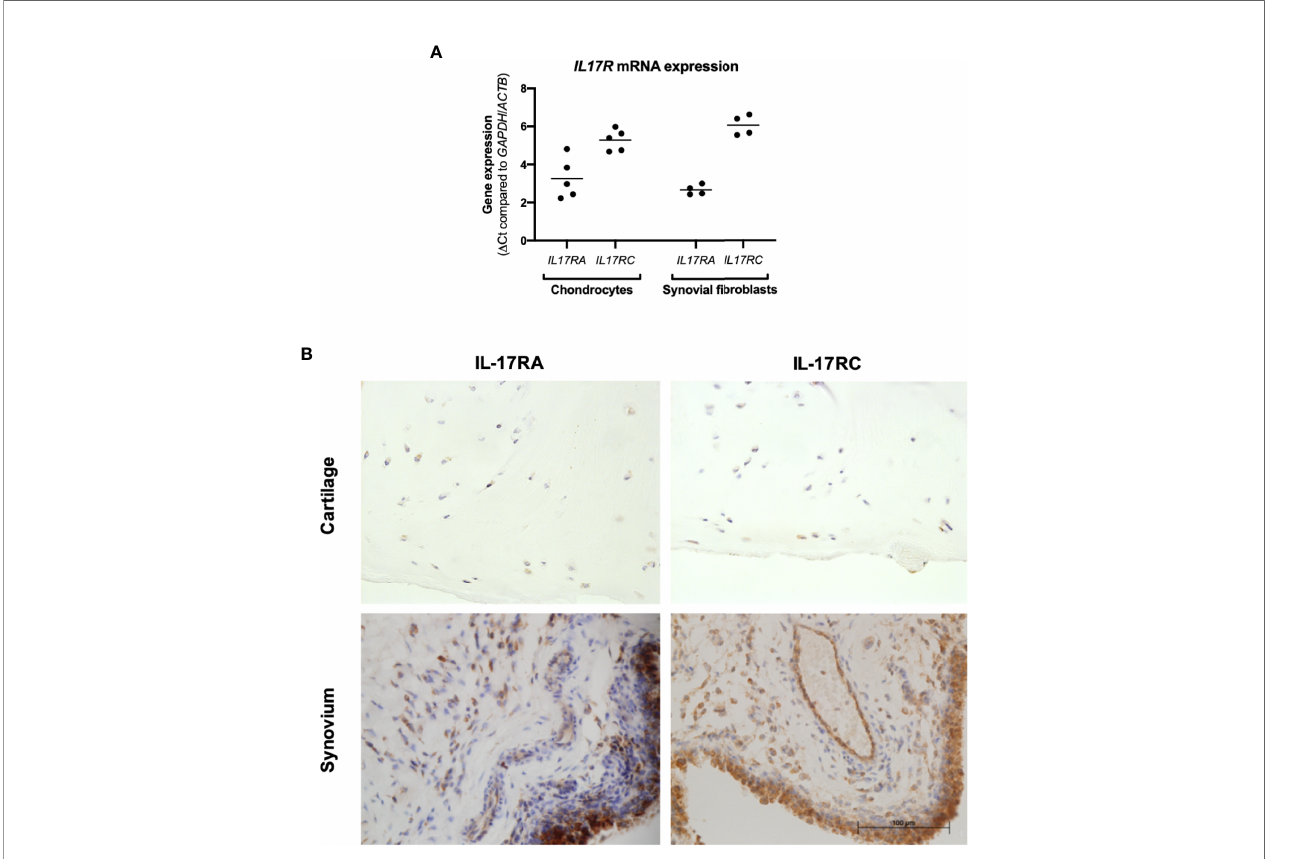
FIGURE 1 | Expression of IL-17 receptor A (IL-17RA) and IL-17RC in end-stage OA. (A) mRNA expression of IL17RA and IL17RC in primary cultured chondrocytes (n=5) and synovial fi broblasts (n=4). Gene expression was calculated using the dCT-method using both GAPDH and ACTB as housekeeper. (B) Protein expression of IL-17RA and IL-17RC in end-stage OA cartilage and synovium. Antibodies were visualised with DAB (brown) and counterstained with haematoxylin (blue). Images were taken at 40x magni fi